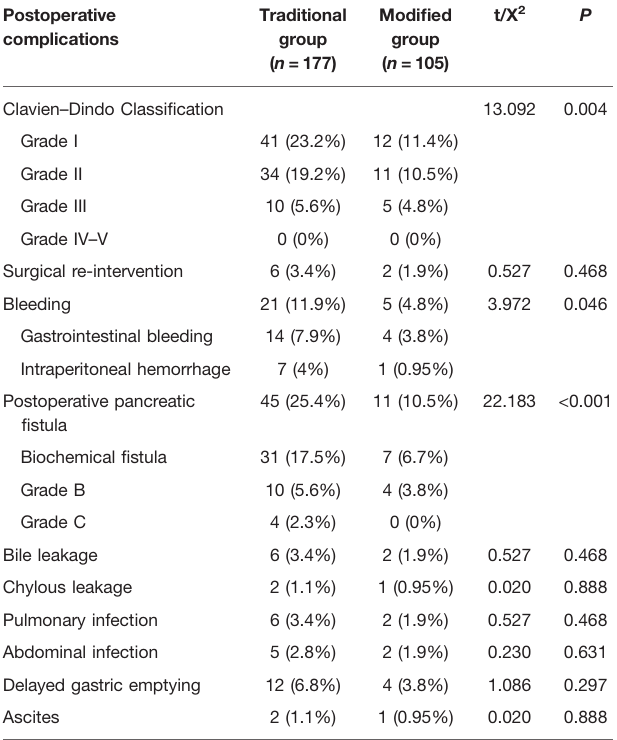
TABLE 2 | Incidence of postoperative complications. Postoperative